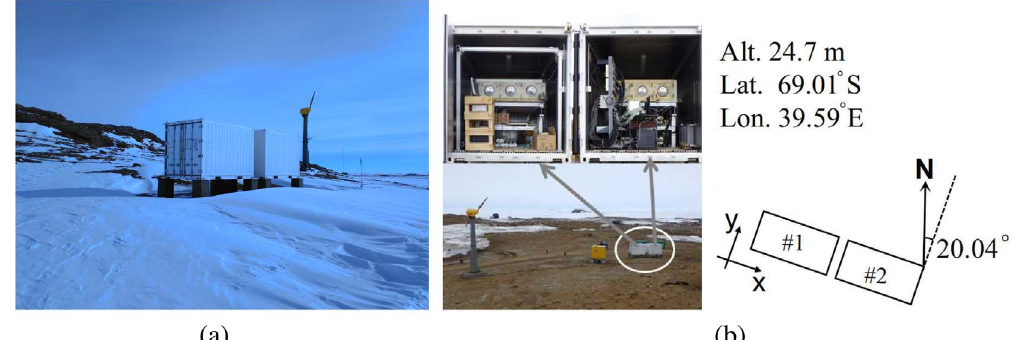
Fig. 1. Containers at Syowa Station. (a) Photo showing the environment of the containers in winter 2018. (b) Photo showing CR detectors installed inside containers. Location and orientation of the containers are also indicated.